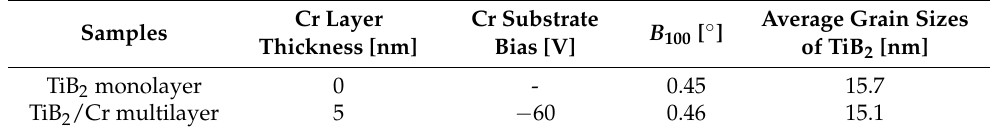
Table 2. Average grain sizes of dcMS-TiB 2 monolayer and TiB 2 /Cr multilayer films.